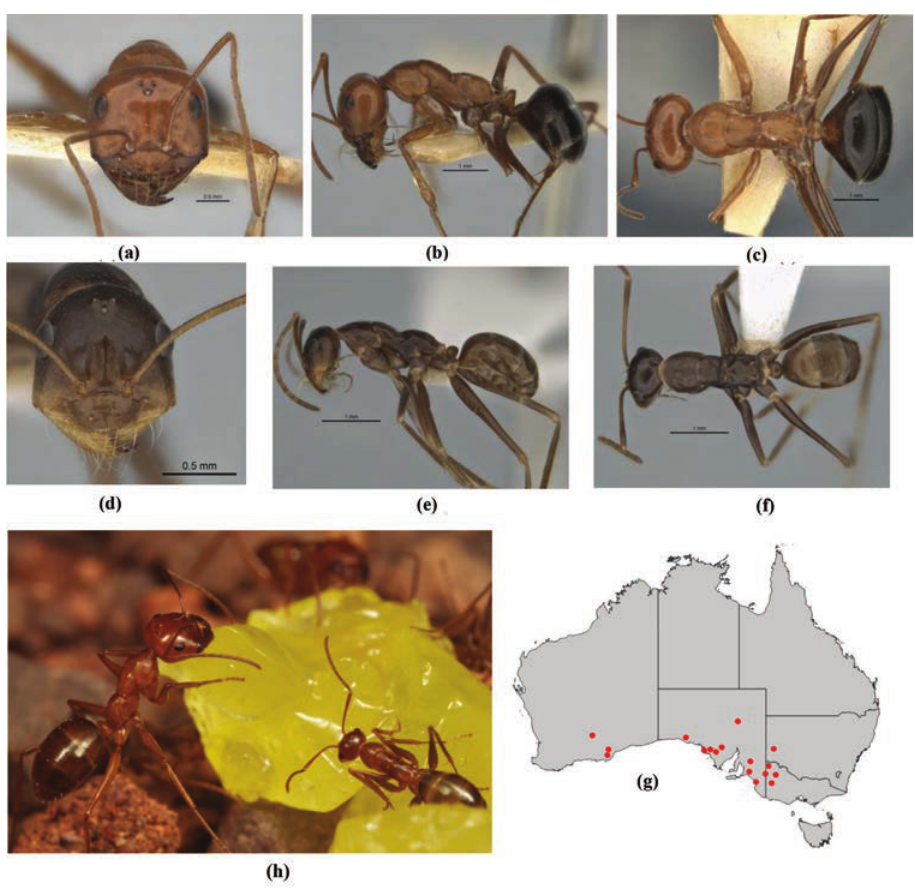
Figure 25. Melophorus nemophilus sp. n.: media worker holotype (ANIC32-900077–top ant) frons ( a ), profile ( b ) and dorsum ( c ); non–type minor worker (ANIC32-030935) frons ( d ), profile ( e ) and dor- sum ( f ); Melophorus nemophilus minor and major worker at bait (photo credit: A. J. Narendra) ( g ); distri- bution map for the species ( h ). Low resolution scale bars: 1 mm ( b, c ); 0.5 mm ( e, f